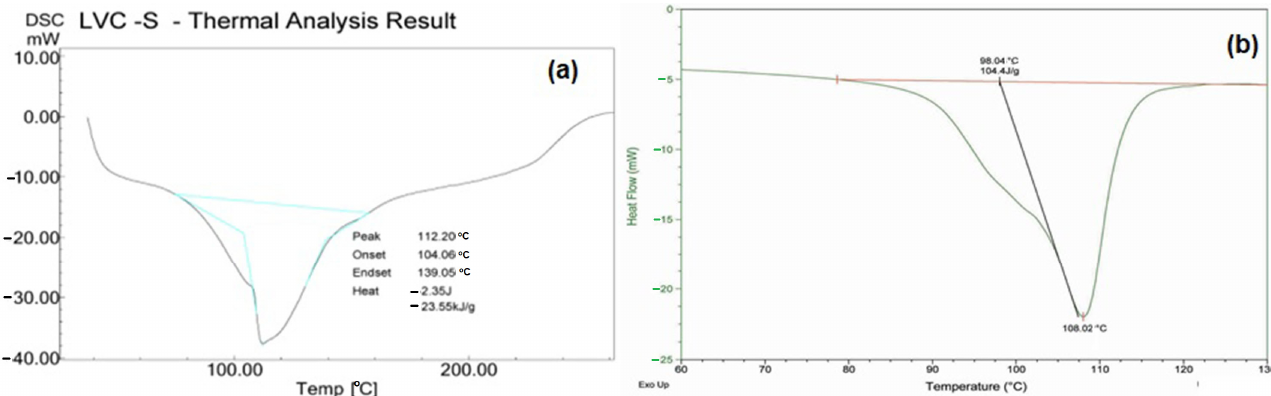
Figure 7. DSC thermogram of ( a ) CRL-MC and ( b ) CRL-NC; Blue line—total area of the peak, Red line—onset to end set of temperature, and Black line—midpoint (onset) of temperature.